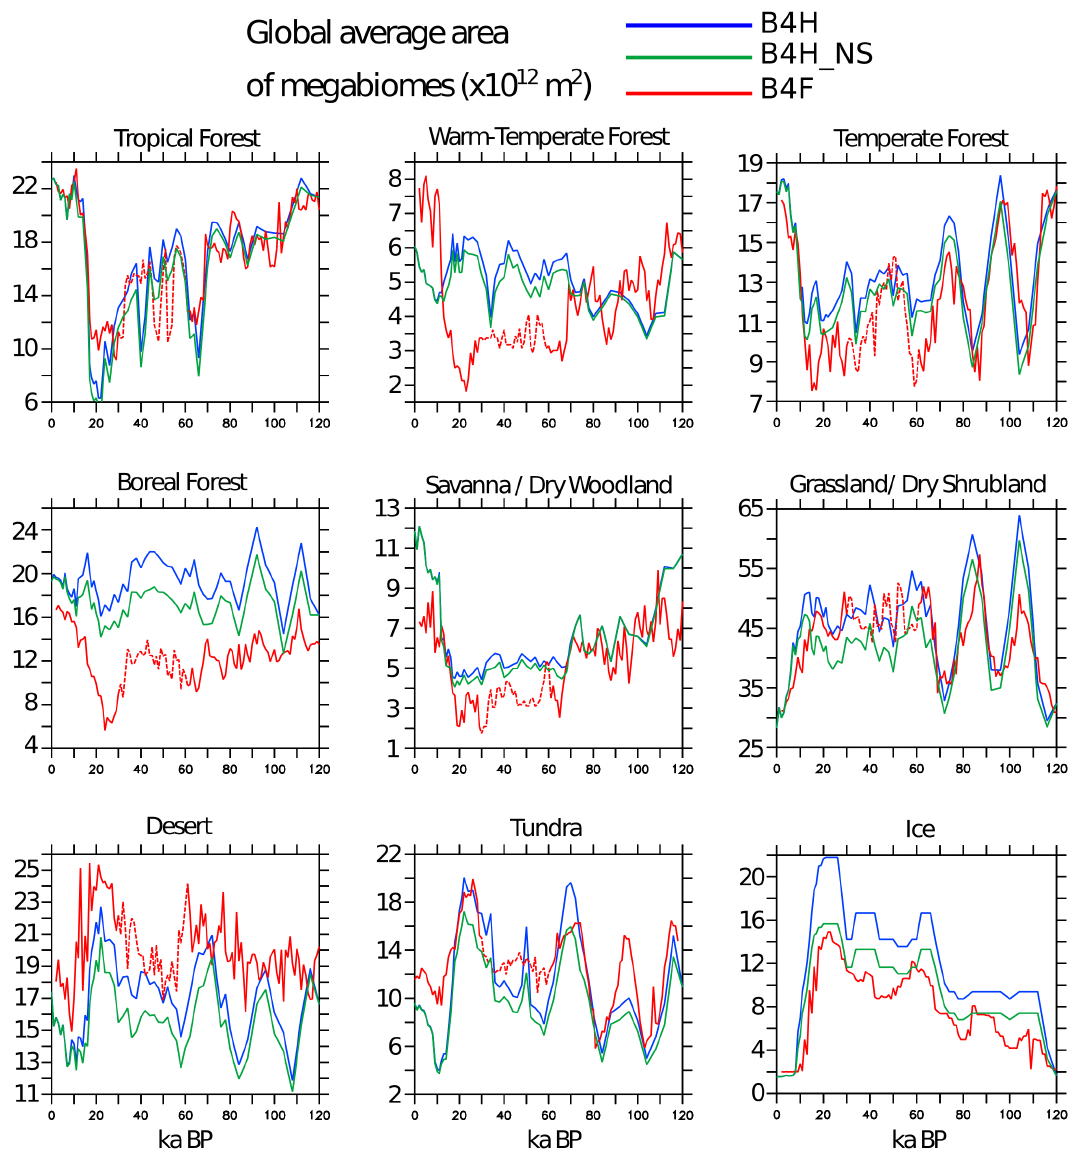
Figure 3. Global area coverage of megabiome types in the model reconstructions. S indicates the inclusion of potentially vegetated continen- tal shelves after sea level lowering, and NS indicates no vegetated continental shelves following sea level lowering. FAMOUS megabiome areas are represented by a dotted line between 30 and 60ka BP in the period where the Vostok CO 2 data used to force the simulation is thought to be erroneously